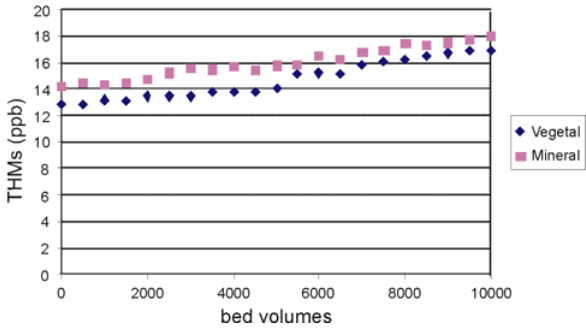
Fig. 5b. THMs (sum) concentrations as a function of bed vol-